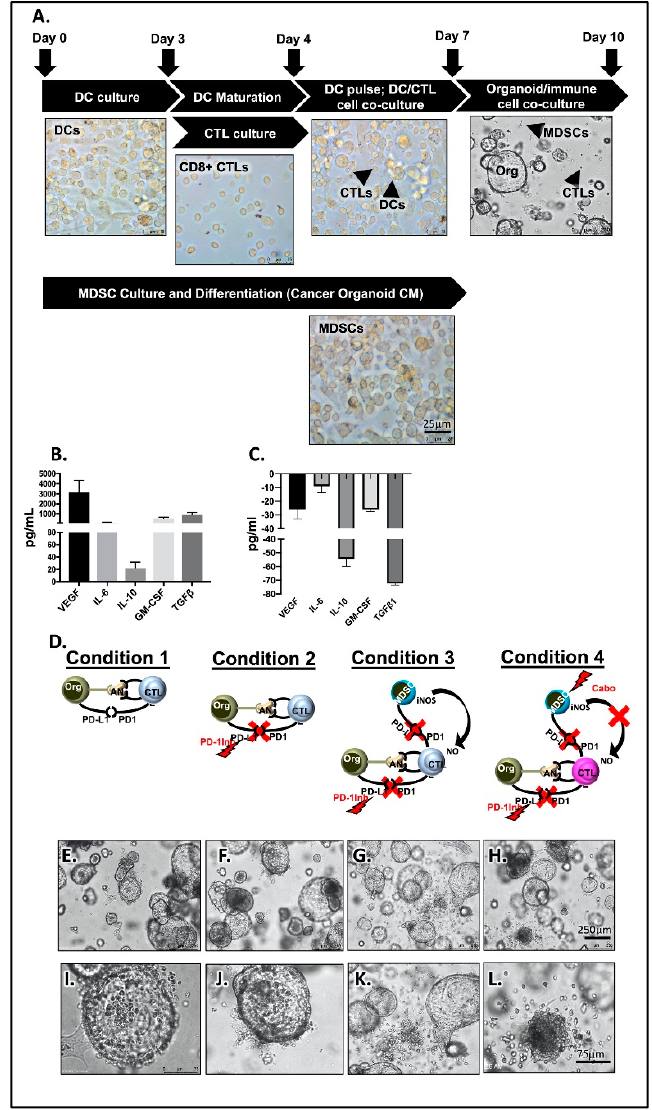
Figure 3. Murine-derived autologous pancreatic cancer organoid / immune cell co-cultures. ( A ) Light micrographs of representative images of immune cells cultured. Luminex assay measuring changes in VEGF, IL-4, IL-10, GM-CSF and TGF β in conditioned media collected from ( B ) tumor and ( C ) normal organoid cultures. ( D ) Schematic representation of experimental conditions 1, 2, 3 and 4 used in organoid / immune cell co-cultures. Representative light micrographs of organoid / immune cell co-cultures captured in conditions ( E ) 1, ( F ) 2, ( G ) 3, and ( H ) 4. Higher magnifications of conditions ( I ) 1, ( J ) 2, ( K ) 3, and ( L ) 4.